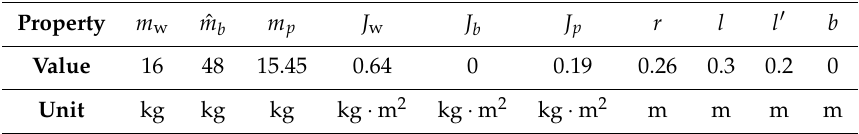
Table 2. Physical parameters of the two-wheeled robotic wheelchair and movable mechanism for